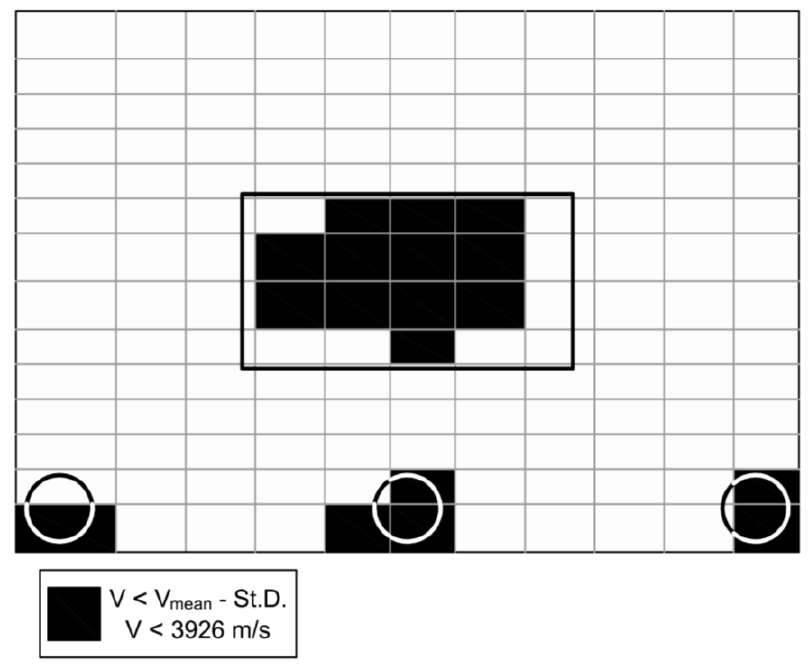
Figure 9. Map 7: Grid B. Defective areas.